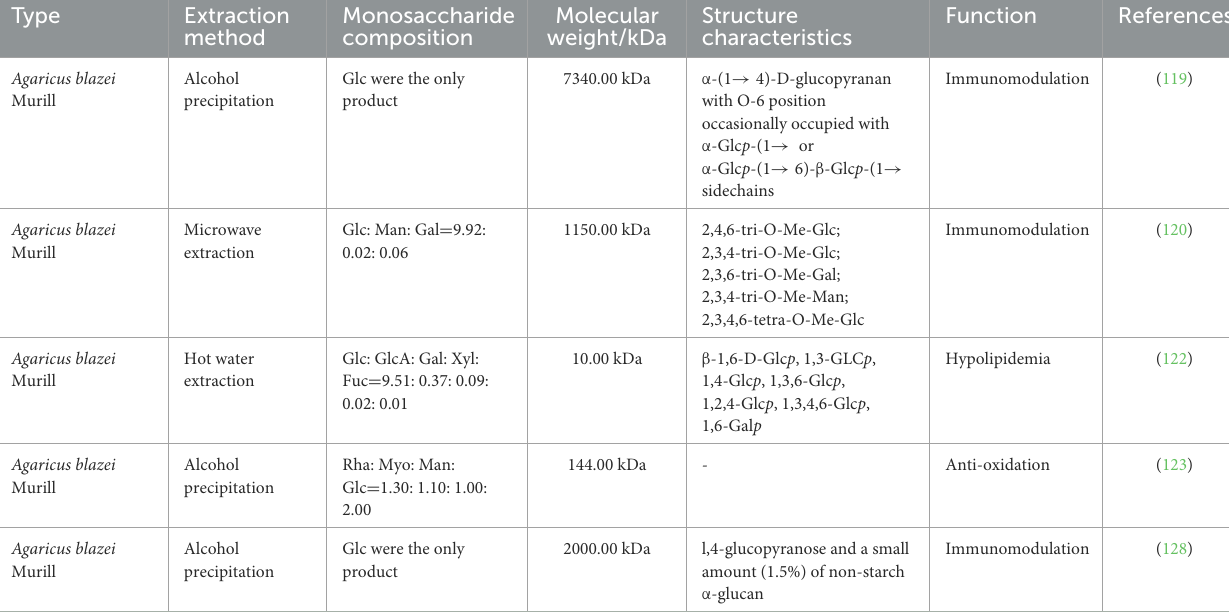
TABLE 7 Structure and structure-activity-relationship of polysaccharide from Agaricus blazei Murill. Type Extraction Monosaccharide Molecular Structure method composition weight/kDa characteristics